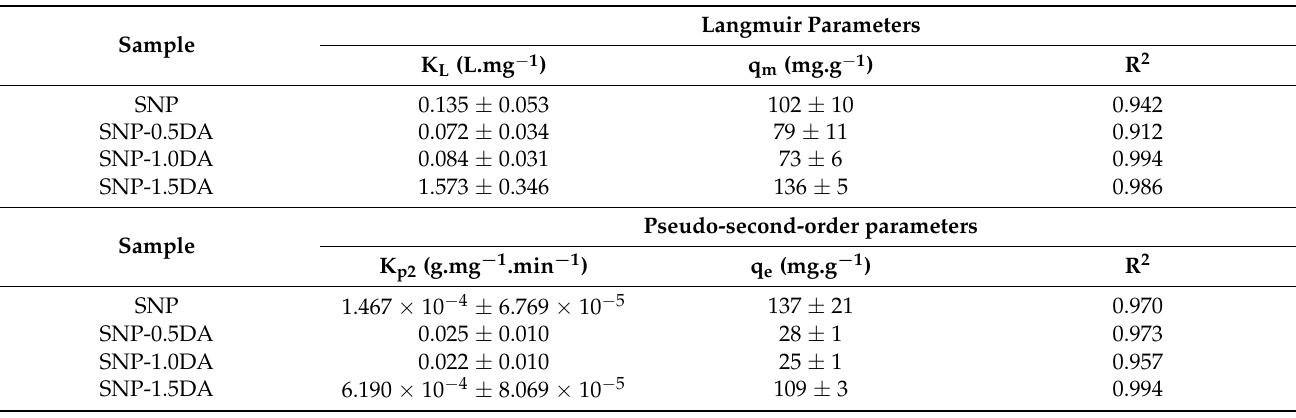
Table 3. The Langmuir adsorption isotherm model parameters and the pseudo-second-order kinetic model parameters for the prepared